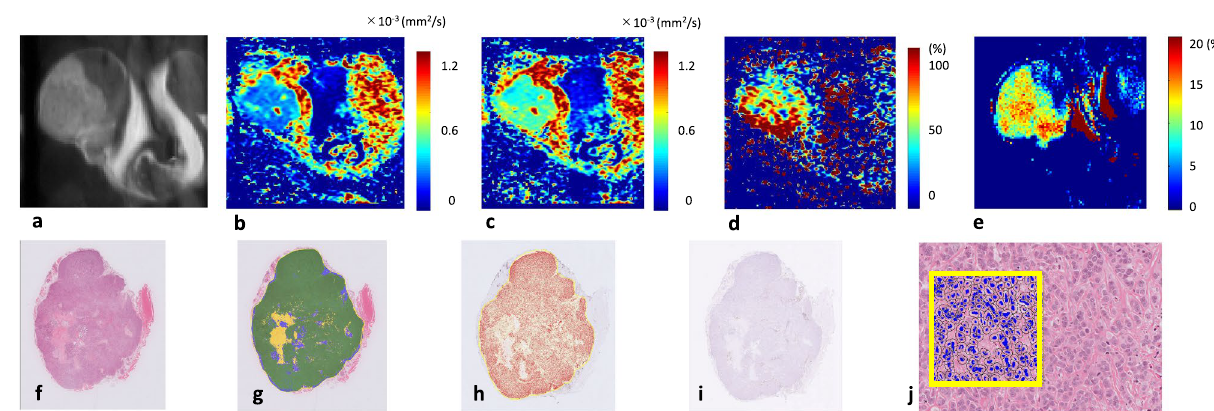
Figure 6. Representative case of MCF-7 tumor. MR images: ( a ) T2WI, ( b ) sADC map (diffusion time, T d = 9 ms), ( c ) sADC map (T d = 27.6 ms), ( d ) ΔsADC 200–1500 map, ( e ) APT imaging map, and whole tumor histological images: ( f ) H&E staining, ( g ) cellular area map, ( h ) Ki-67-positive cell map, ( i ) CD31 staining. ( j ) H&E staining on high power magnification (× 400). Yellow line squares with 200 μm sides were drawn on ( j ). The decrease of ADC with T d is evident. The dorsal part of the tumor shows high ΔsADC 200–1500 and APT